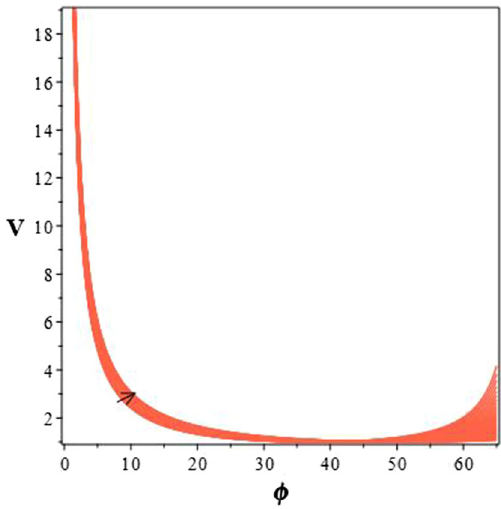
Fig. 4 The evolution of the slow-roll parameter (cid:13) of the intermediate MDBI model versus the e-folds number during inflation, with b = 10 and 0 . 340 < β < 0 . 400. The arrow shows the direction in which the parameter β